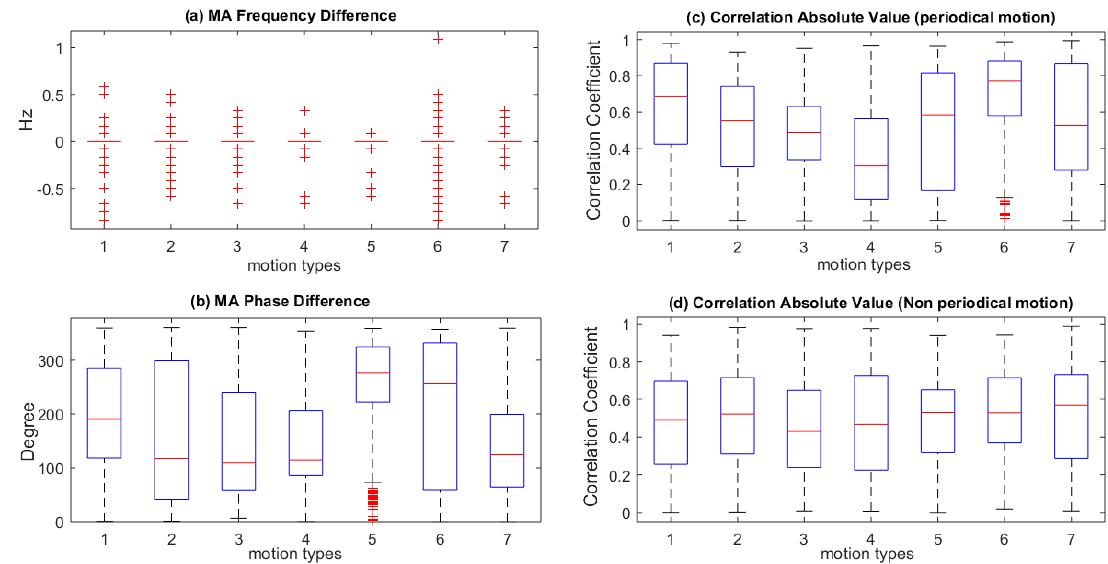
Figure 3. Correlation between MA in green and IR PPG: ( a ) Boxplots of the frequency difference between the frequency of the MA in the green and the IR channels for the seven types of periodic motion. Due to similarity in these frequency components the median, interquartile range and whiskers overlap. The outliers are visible.; ( b ) Phase difference between the MA in the green and the IR channel during the seven types of periodic motion; ( c ) Correlation coefficient between the motion in the green and the IR channel during the seven types of periodic motion; ( d ) Correlation coefficient between the motion in the green and the IR channel for the seven types of continuous non-periodic motion.